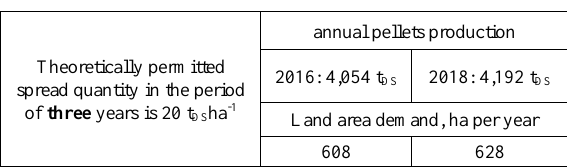
Table 4. Determination of quality indicators